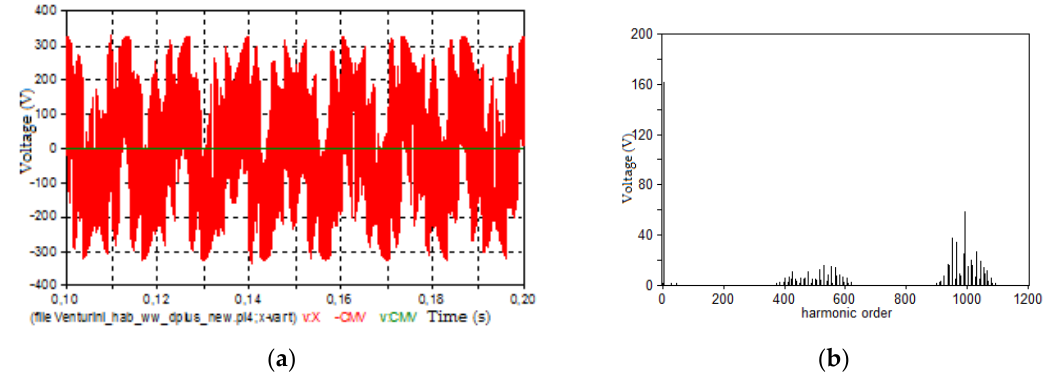
Figure 7. Waveforms of the output voltages (red lines) and CMV (green line) ( a ) and Fourier analysis of the output voltage ( b ), synthesized in MMC and controlled by the use of CW rotating space vectors, for the angle ψ = 0 ◦ and output frequency of 80 Hz.